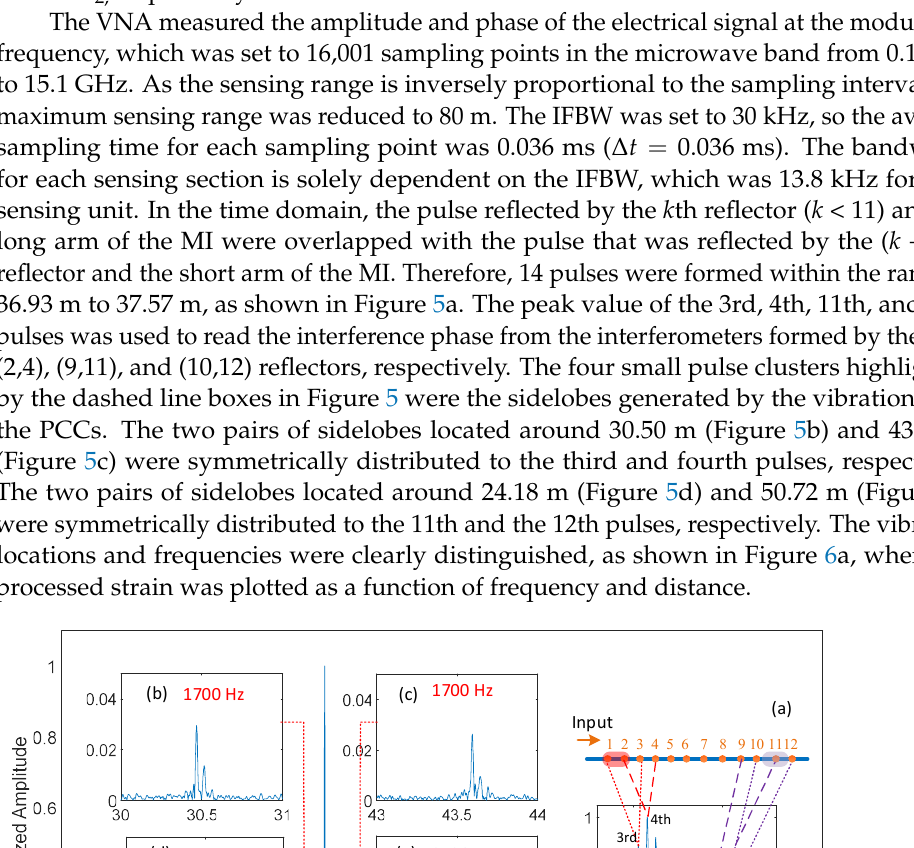
Figure 6. ( a ) Strain as functions of frequency and distance. ( b ) Driving signal (upper) to PCC 1 and the reconstructed temporal signals centered at 37.03 m and 37.08 m (lower). ( c ) Driving signal (up- per) to PCC 2 and the reconstructed temporal signals centered at 37.43 m and 37.48 m (lower). The temporal signal reconstruction was performed by following the steps shown in Figure 4a. Time-domain gates that truncated the main pulse and the respective sidelobe at 1700 Hz and 3430 Hz were applied to the four affected sensing units separately in Step 2. The reconstructed temporal signals from the sensing units centered at 37.03 m and 37.08 m were both in phase with the driving signal to PCC 1, as shown in Figure 6b. The recon- structed temporal signals centered at 37.43 m and 37.48 m were both in phase with the driving signal to PCC 2, as shown in Figure 6c. The strain amplitude was proportional to the contact length between the sensor unit and their respective PCC. The strain amplitude read from the sensor unit centered at 37.03 m was larger than that at 37.08 m, as the PCC 1 was attached to the fiber section from 36.98 m to 37.03 m. Likewise, the strain amplitude read from the sensor unit centered at 37.48 m was larger than that at 37.43 m, as more than half of the taped fiber section to PCC 2 was after 37.48 m. The results show that the phase and amplitude of the acoustic signal are well resolved in the reconstructed temporal signals. The amplitude of 19.5 nε at 37.08 m was clearly identified, indicating a lower detection limit, less than that for the experiment setting. The strains from the sensor units that are 5 cm apart are distinguishable, demonstrating a spa- tial resolution of 5 cm for DAS. Note that there are three terms to describe the range resolution: spatial resolution ( S R ), range sampling resolution ( r S ), and gauge length ( L G ). In this paper, S R refers to the